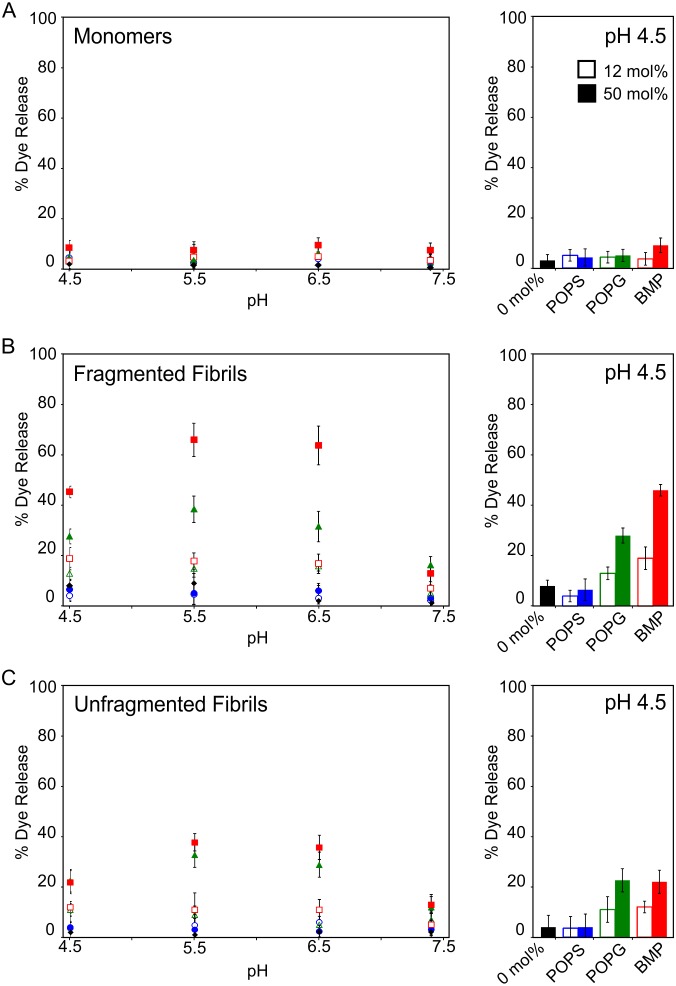
Dye release from LUVs comprised of complex anionic lipid mixtures upon addition of β2m samples at pH 4.5–7.4.Dye release was measured 10 min after the addition of 6 µM (monomer equivalent concentration) of (A) β2m monomers, (B) fragmented fibrils or (C) unfragmented fibrils added to CF-loaded LUVs (5 µM lipid) in Assay Buffer pH 4.5–7.4, 37°C. LUVs are comprised of 36 POPC: 20 POPE: 7 SM: 25 cholesterol (mol/mol) doped with 0 mol % (diamond, black), 12 mol % (open symbols) or 50 mol % (solid symbols) anionic lipid, POPS (circle, blue), POPG (diamond, green) or BMP (square, red). Corresponding bar graph of dye release at pH 4.5 in 0 mol % (black), 12 mol % (open bar) or 50 mol % (solid bar) POPG, POPS or BMP are shown alongside. Error bars represent 1 standard error (S.E.) from three independent repeats, each of three replicates.